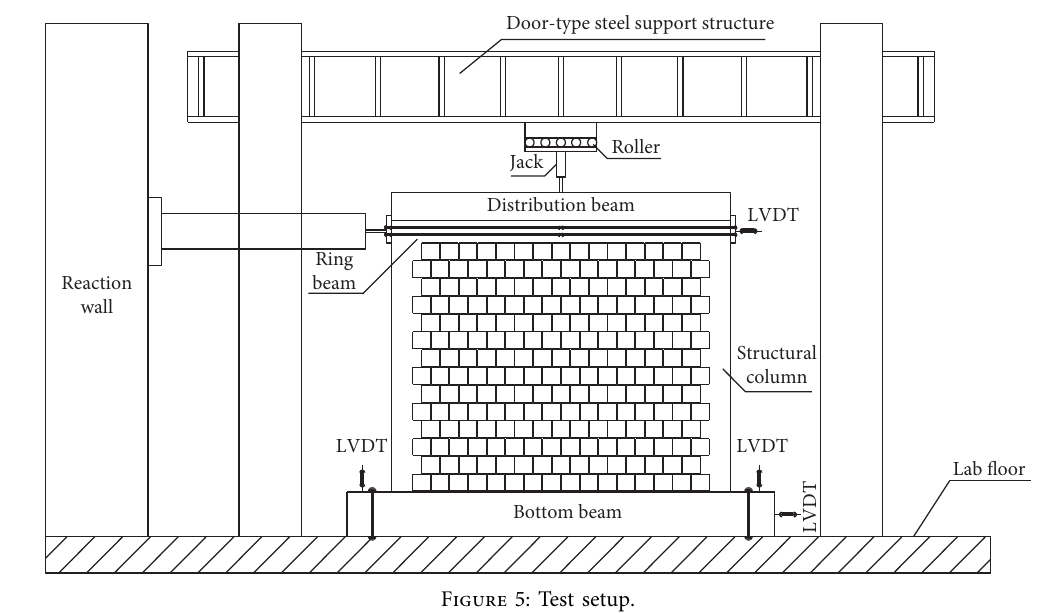
Figure 5: Test setup.